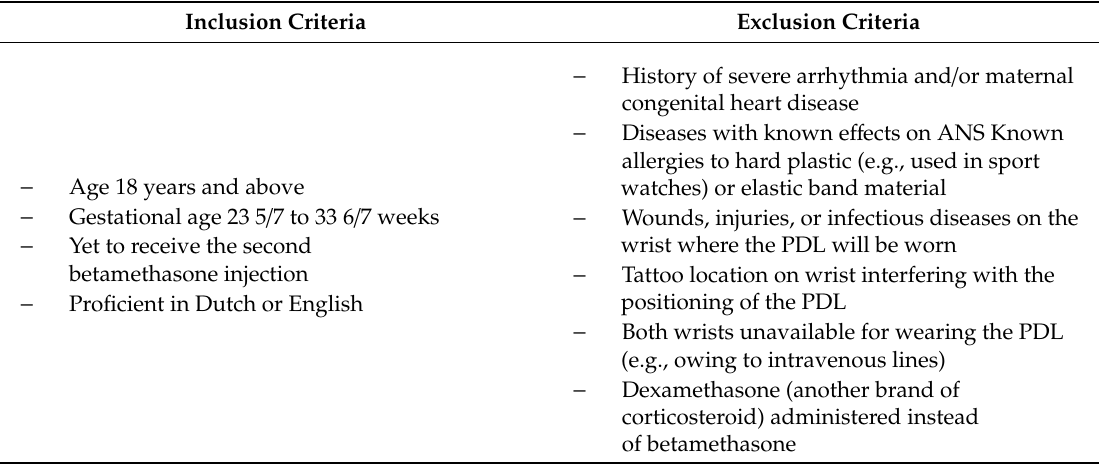
Table 1. Inclusion and exclusion criteria for MAMA-hart